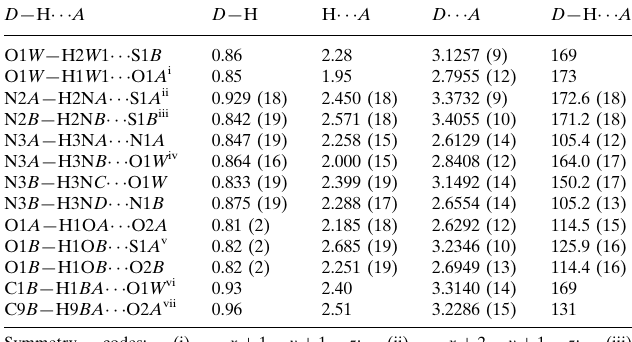
Key indicators: single-crystal X-ray study; T = 100 K; mean (cid:1) (C–C) = 0.002 A˚; R factor = 0.042; wR factor = 0.116; data-to-parameter ratio = 34.5.